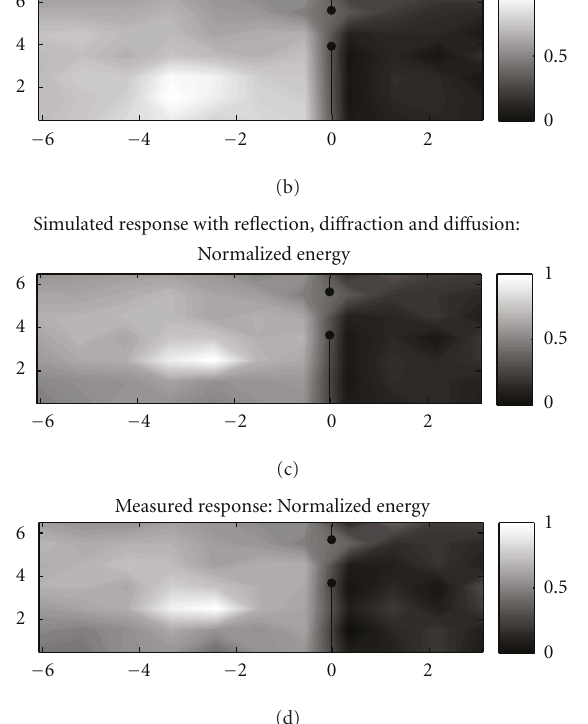
Figure 21: Center Time map: measured (a) simulated with reflections only, (b) simulated with reflections and di ff raction, (c) simulated with reflections, di ff raction and di ff usion, (d)